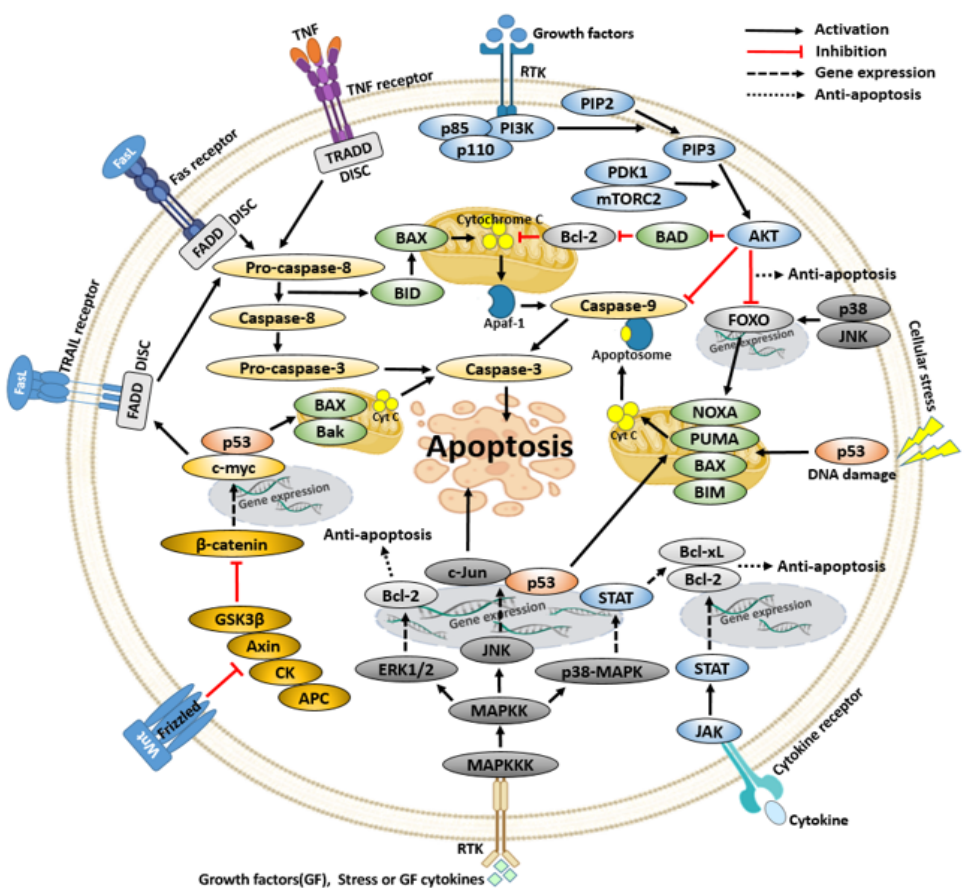
Figure 4. Various signaling pathways involved in apoptosis.